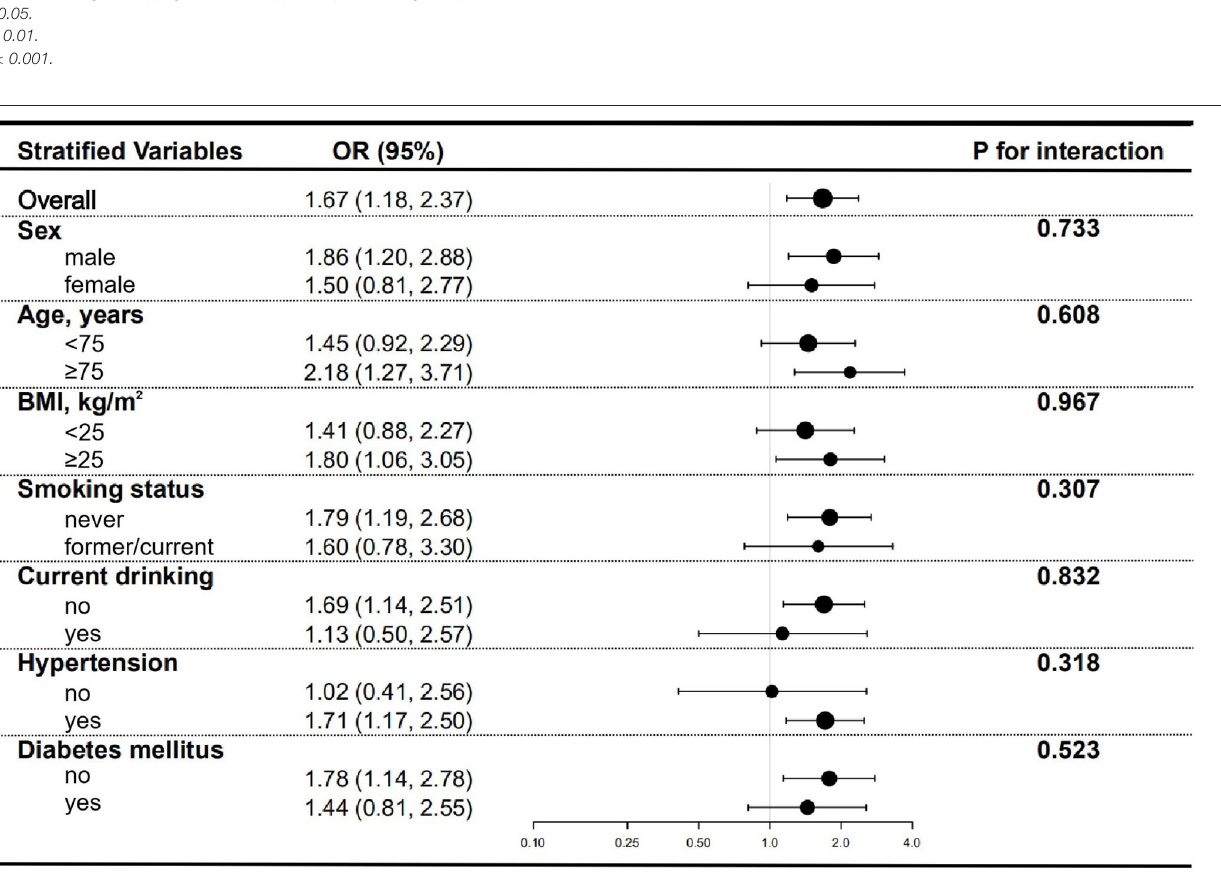
FIGURE 3 | Subgroup analyses for the association between TyG index and high baPWV. Adjusted for age, sex, BMI, waist circumference, SBP, DBP, TC, HDL-C, LDL-C, eGFR, smoking status, drinking status, CHD, hypertension, diabetes mellitus, anti-platelet agents, anti-hypertensive agents, hypoglycemic therapy, and lipid-lowering therapy except for the stratified